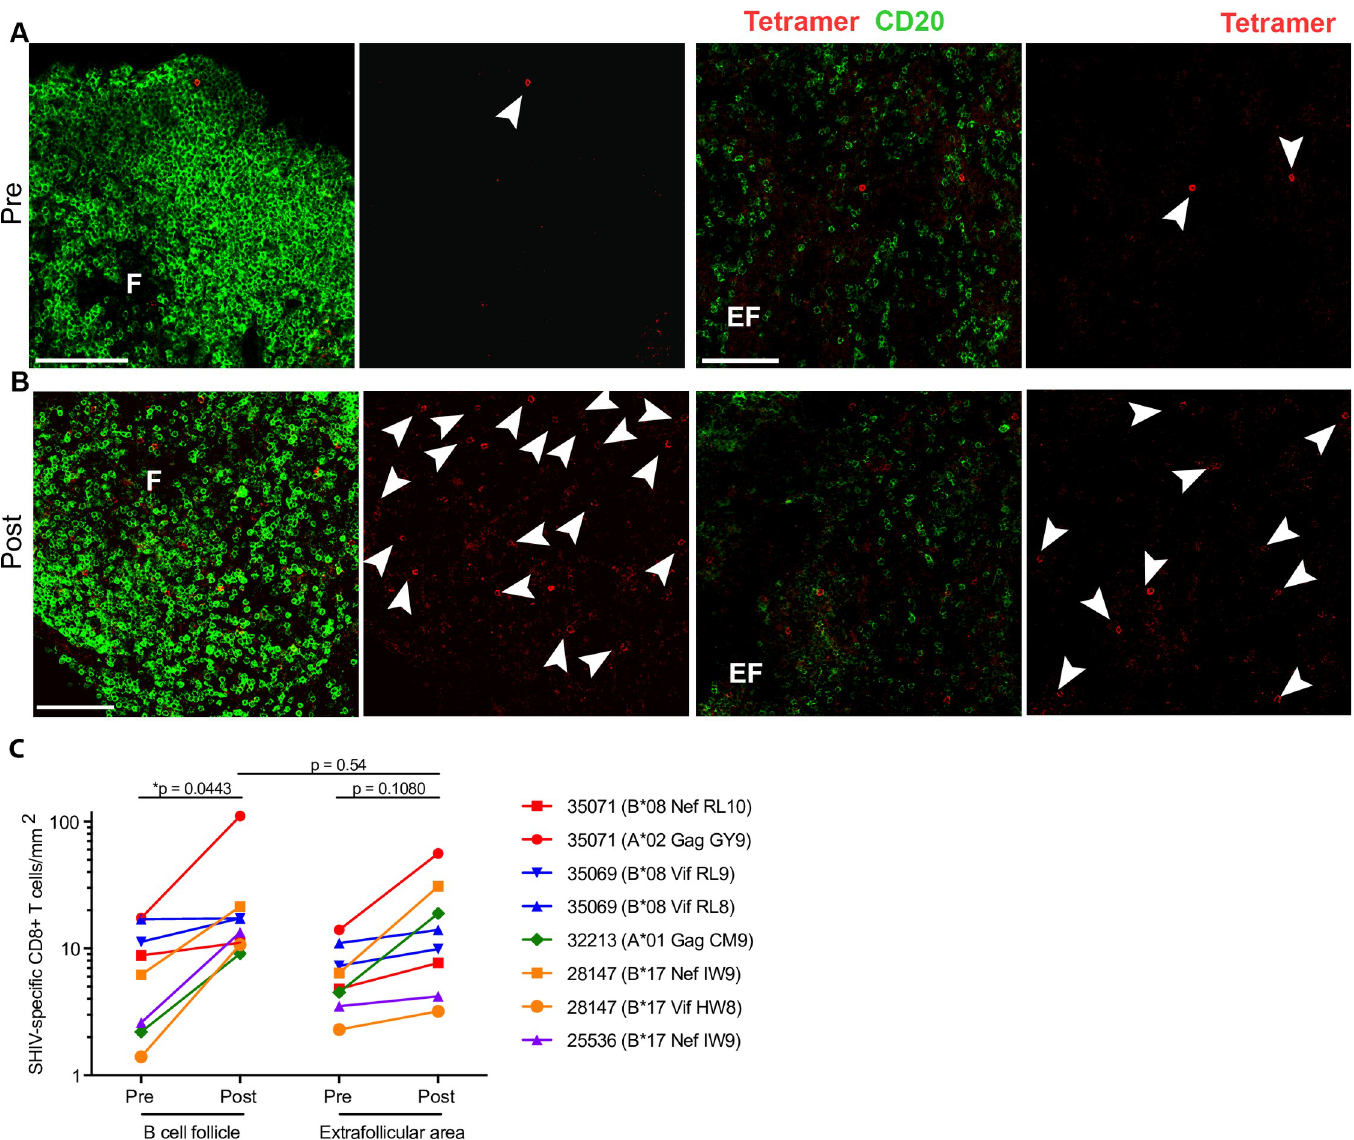
Fig 5. SHIV-specific CD8+ T cells increase in follicular and extrafollicular regions of lymph nodes after N-803 treatment in ART-suppressed macaques. Representative images showing Mamu-B � 08 RL9 tetramer+ cells (red) and CD20+ cells (green) in lymph node sections from animal 35069, (A) before and (B) 5 days after N-803 treatment. CD20 staining is used to define B cell follicles (F) and extrafollicular (EF) regions. Tetramer-binding cell are indicated with white arrowheads. Scale bars indicate 200 μ m (left panels) and 100 μ m (right panels). (C) The numbers of tetramer+ CD8+ T cells per millimeter squared in B cell follicles and extrafollicular area before and 5 days after N-803 treatment. P values were calculated using a linear mixed effects model. � , P < 0.05; �� , P < 0.01; ��� , P <